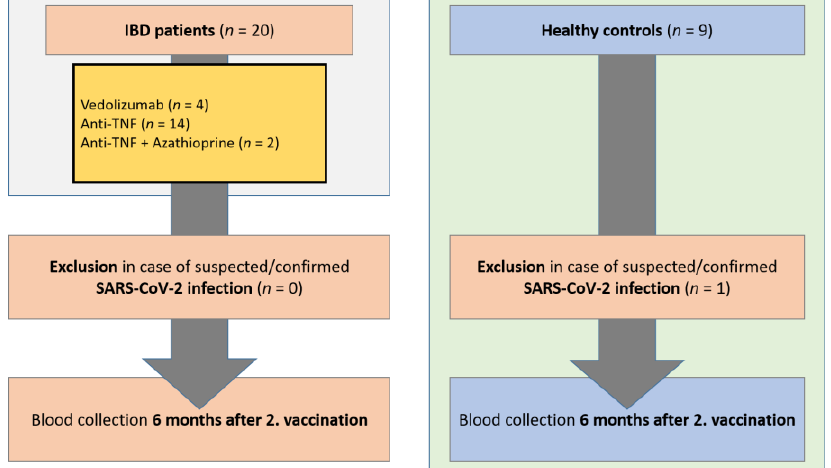
Figure 1. Study flow chart. Inclusion of IBD patients in the period from January 2021 to March 2022 on immunosuppressive medication and healthy controls. Blood collection 6 months following the 2nd vaccination (+/−20 days). Exclusion of patients and controls with suspected or confirmed SARS-CoV-2 infection. IBD, inflammatory bowel disease; SARS-CoV-2, severe acute respiratory syndrome coronavirus-2.